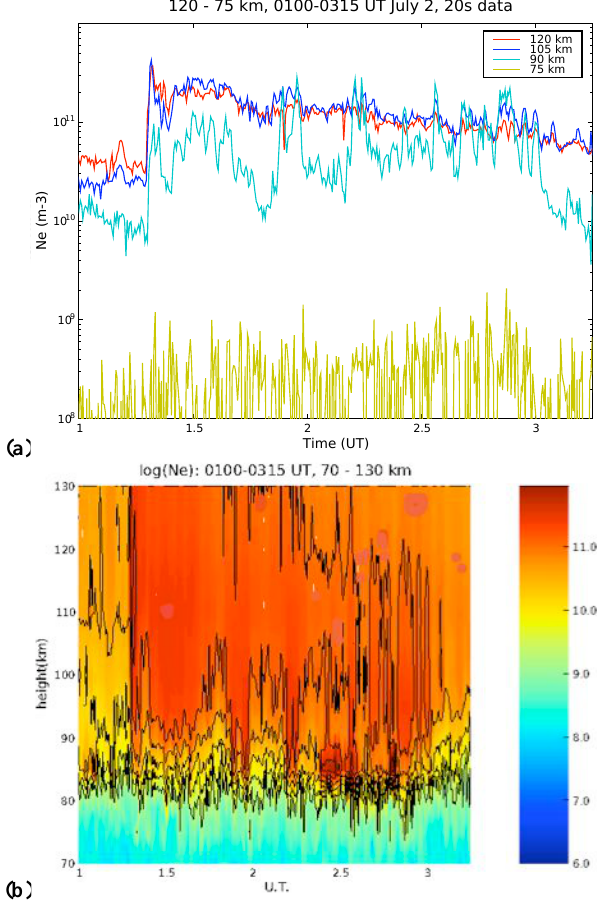
Fig. 9. Electron density at 15-km intervals and contour map from 01:00–03:15 UT on 2 July at 20s time